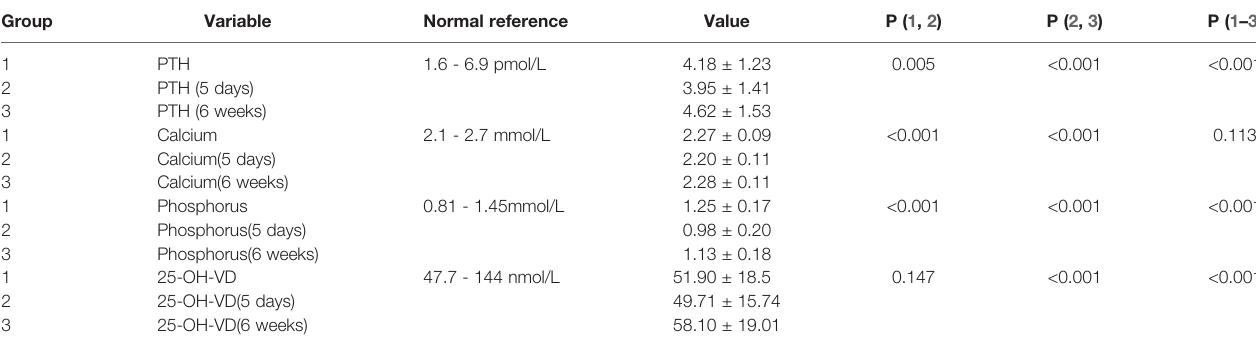
TABLE 2 | Comparison of PTH, serum calcium, phosphorus and 25-OH-VD values at pre-RAI, fi ve days and six weeks